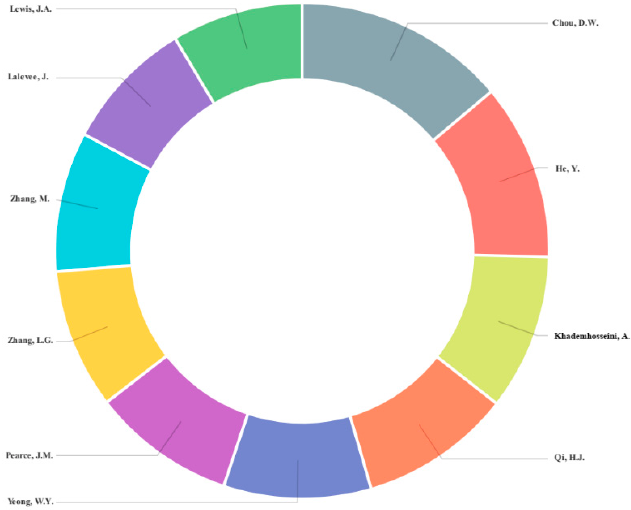
Figure 9. Pie chart of the contributions of the top 10 most productive authors.